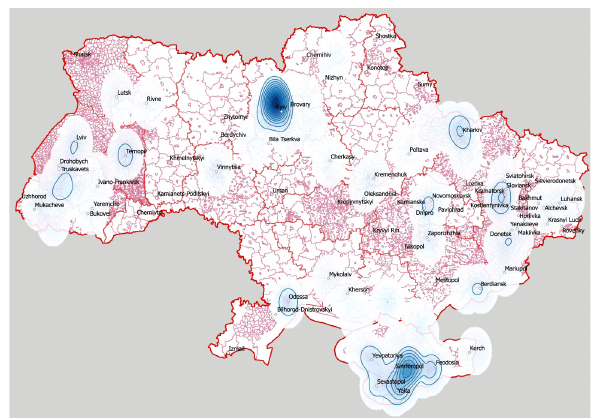
Figure 10. A heatmap (the distribution of zoos in Ukraine) Figure 11. A fragment of a heatmap with overlapping of